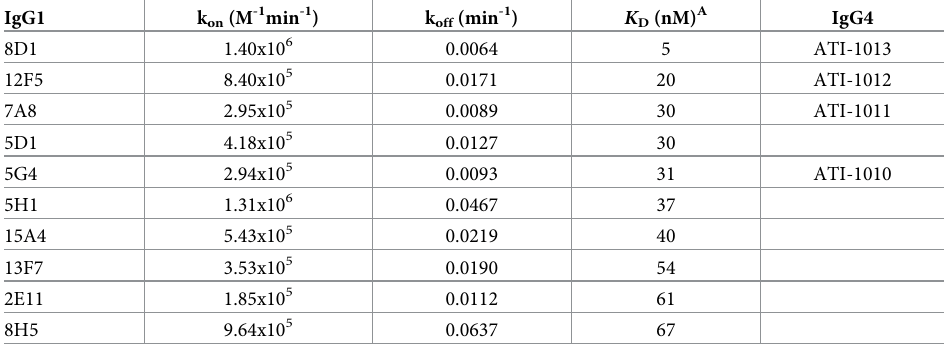
Table 1. Affinity of the 10 most potent nicotine binding IgG1 mAbs and the name of their IgG4 isotype counterparts.